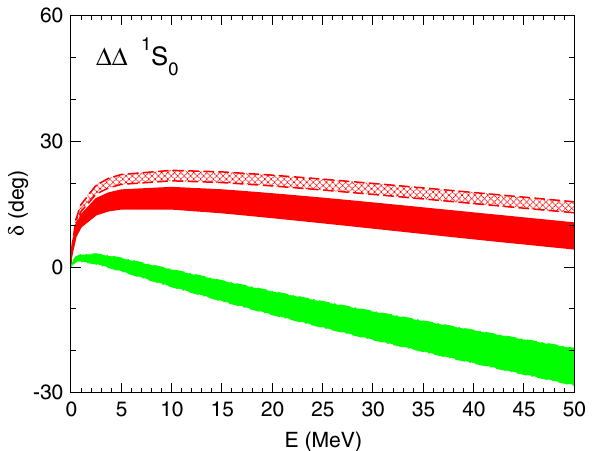
Fig. 2 Prediction for the ΔΔ 1 S 0 phase shift with isospin I = 3 based on the ΩΩ result and SU(3) symmetry. The dark (red) band is based on the C 28 value fixed by a fit to the central HAL QCD result for ΩΩ , while the hatched (red) band corresponds to the maximum HAL QCD result, cf. Fig. 1. The gray (green) band corresponds to the lattice result of Ref. [18]. All results are for physical meson and baryon masses